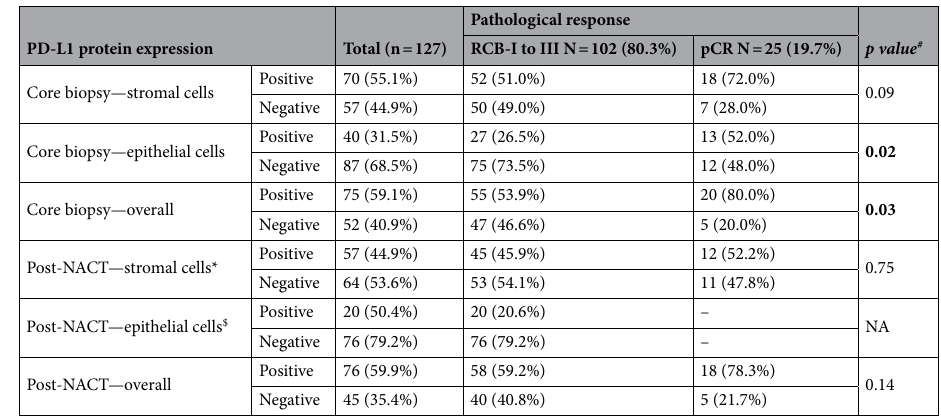
Table 7. Correlation between PD-L1 expression in stroma, and in epithelial cells, in specimens pre and post-neoadjuvant chemotherapy according to pathological response. Values in bold indicate data of statistical significance. pCR Pathological complete response, RCB Residual cancer burden, NACT Neoadjuvant chemotherapy. *Six women (two with pCR and four with RCB) had no tissue post-NACT for immunohistochemical evaluation. $ In thirty-one cases (25 with pCR and 6 with RCB-I), PD-L1 expression in epithelial cells could not be evaluated.NA: not applicable. # p value calculation using Fisher’s exact test.